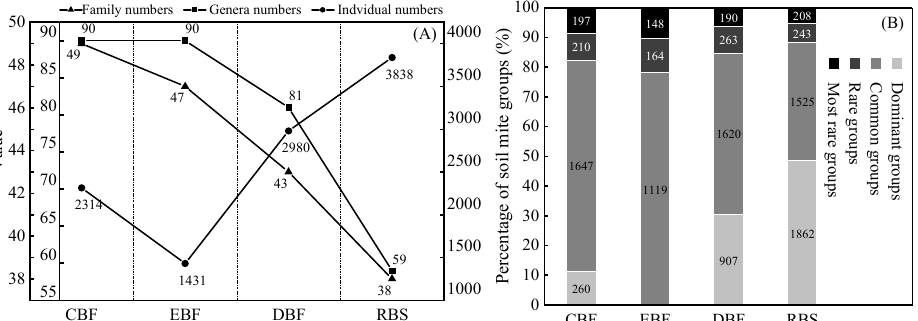
Table 4. Distributions of genera numbers and individual numbers of soil mites (Mean ± SE, n = 3).